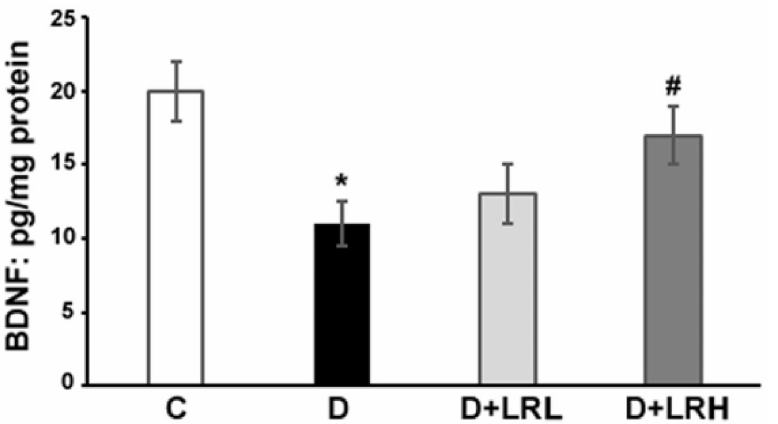
Figure 1. BDNF levels in the retinas of L. regularis -treated diabetic and control rats. Retinal BDNF levels were measured using an ELISA kit. BDNF levels in diabetic retinas were compared with L. regularis -treated diabetic rats and control rats. The values are means ± SEM (standard error of mean) (* p < 0.01 vs. control; # p < 0.05 vs. diabetes, N = 6). C (control), D (diabetic) D + LRL (low-dose L. regularis -treated diabetic rats), and D + LRH (high-dose L. regularis -treated diabetic rats. The experiment was repeated twice.